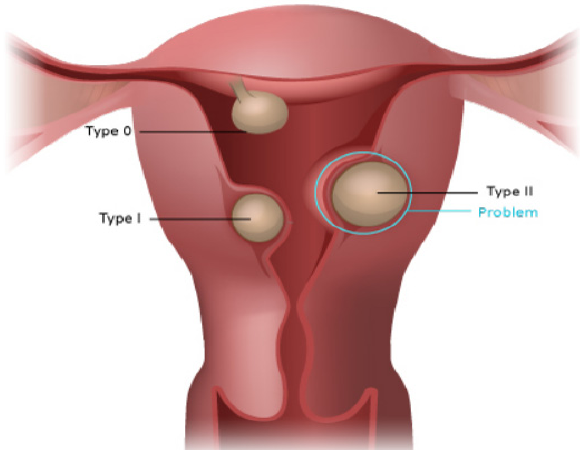
Figure 2. ESGE classification of submucous myomas. They classified the submucous myomas into three groups according to their protruding %: <50%, 50–79%, and >80%. From: three groups according to their protruding %: <50%, 50–79%, and >80%. From: (https://elearning. (https://elearning.rcog.org.uk//uterine-cavity-surgery/hysteroscopic-myomectomy/classification- rcog.org.uk//uterine-cavity-surgery/hysteroscopic-myomectomy/classification-submucous, ac- submucous, accessed on 30 August 2022). cessed on 30 August